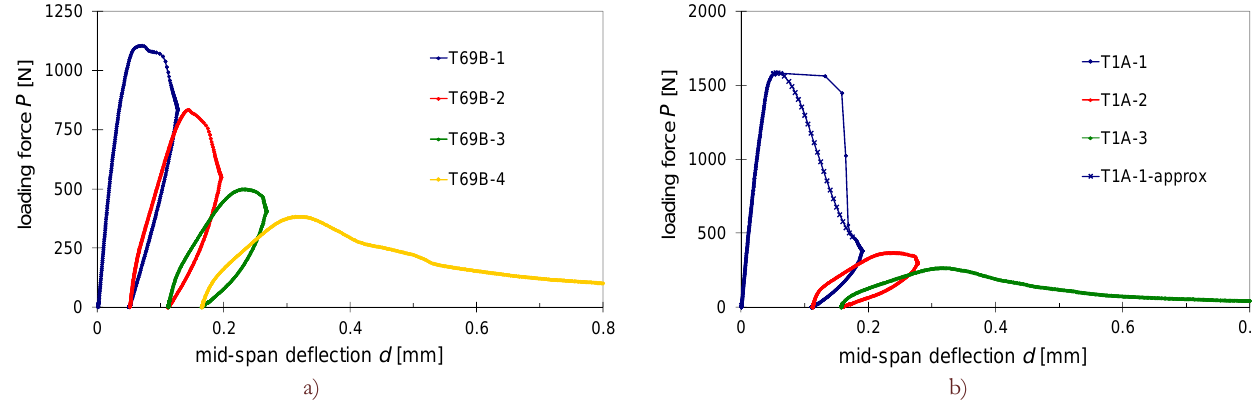
Figure 2: Example of recorded load vs. mid-span deflection curves ( P – d diagrams); a) with quasi-static fracture propagation (specimen T69B), b) with a dynamic event on the descending branch of the first loading cycle (specimen